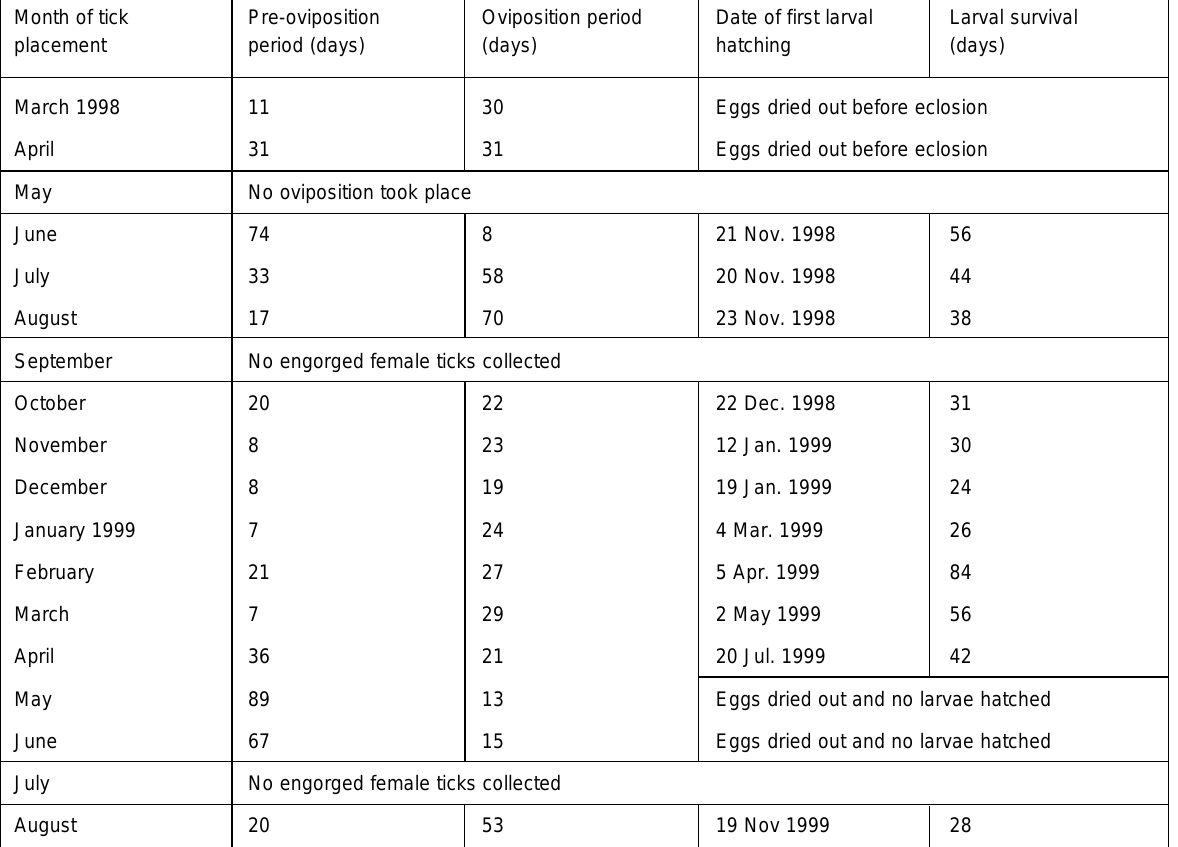
TABLE 1 Pre-oviposition period, oviposition period and subsequent survival of the larval progeny of engorged female Rhipicephalus (Boophilus) decoloratus exposed to ambient outdoor climatic